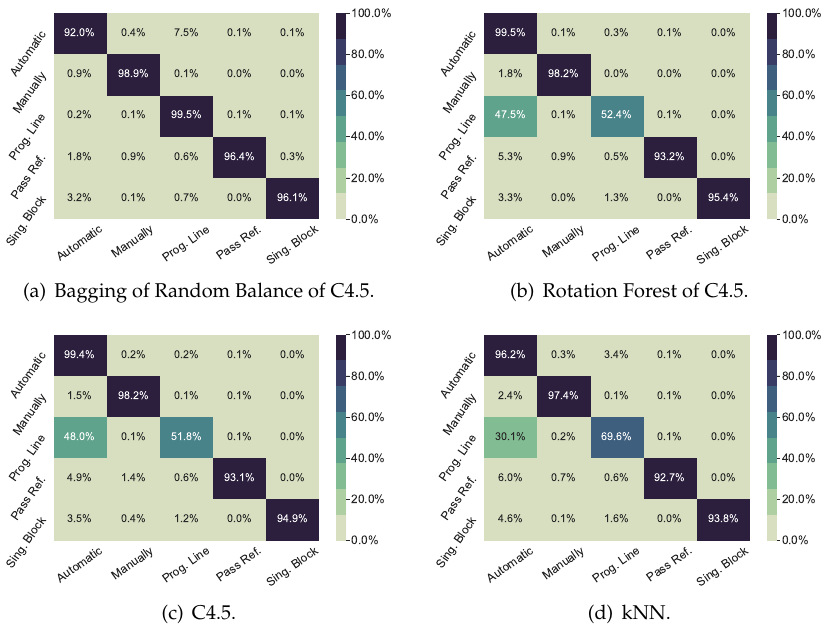
Figure 2. Confusion matrix over Mode .